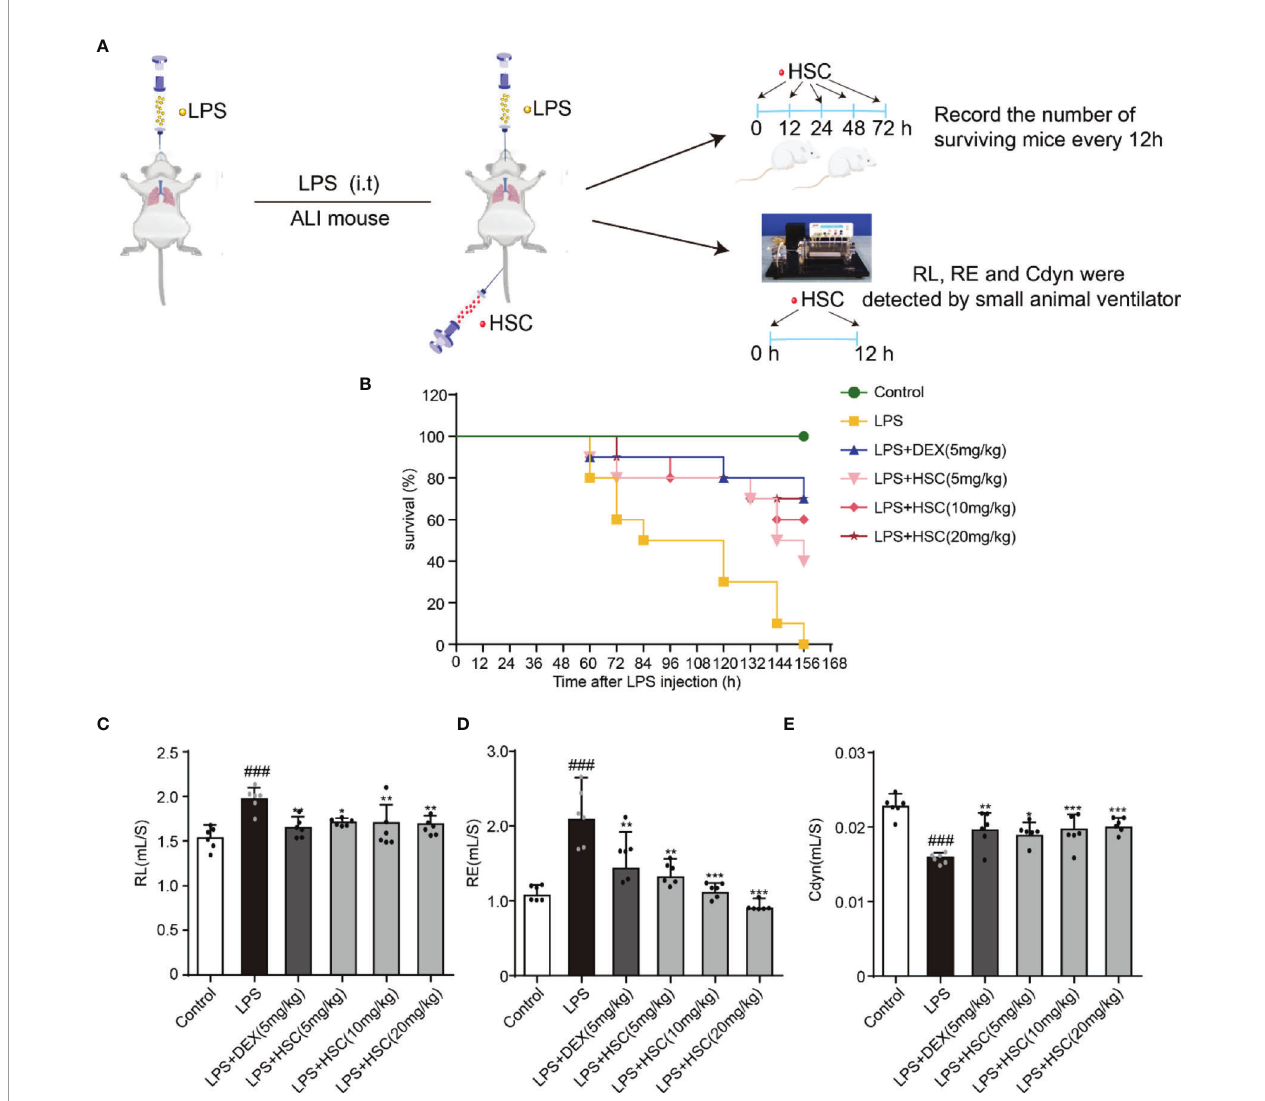
FIGURE 7 | HSC protected LPS-induced ALI and improves respiratory function. (A) The mice were treated with LPS (15 mg/kg, i.t.), and treated with HSC (5, 10, and 20 mg/kg, i.v.) for 0, 12, 24, 48, and 72 h. Dexamethasone (DEX; 5 mg/kg, i.p.) was used as a positive control. (B) The survival rates of all the mice were observed for a period of 168 h, (n=10). (C-E) The mice were treated with LPS (4mg/kg, i.t.). After LPS injection, mice were treated with HSC at 0 and 12 h. After 24h, blood samples were collected, neutrophils, (C) Resistance of lung (RL), (D) resistance of expiration (Re), and (E) respiratory lung compliance (Cdyn) levels were detected using an AniRes2005 lung function test system, (n=6). ### P < 0.001 compared to control alone group; * P < 0.05, ** P < 0.01, and *** P < 0.001 versus the LPS